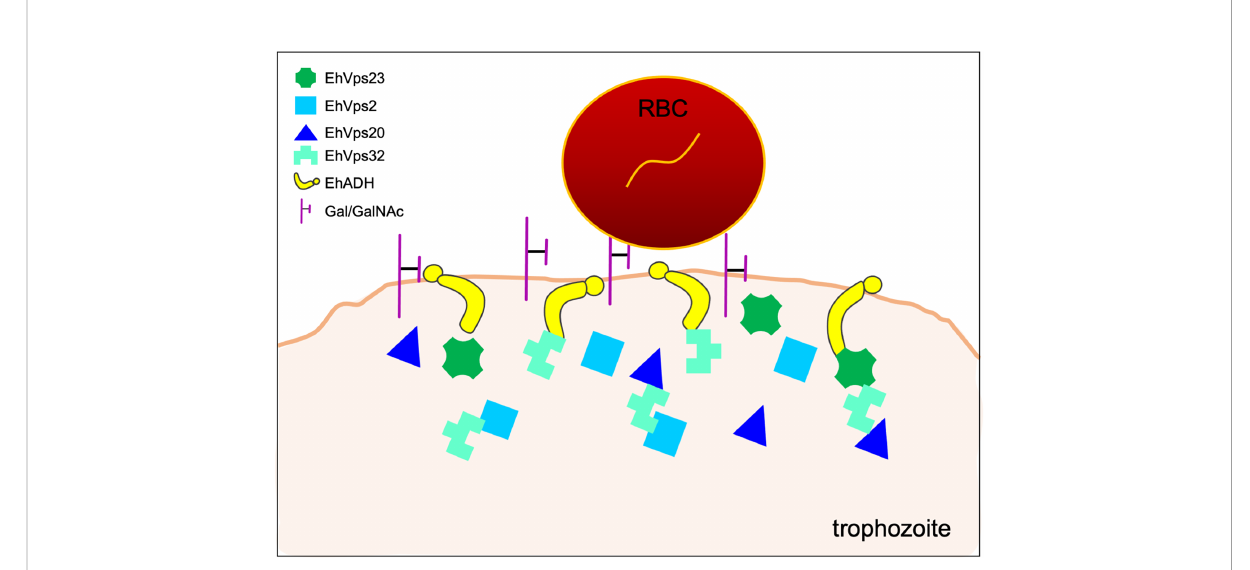
FIGURE 1 Initial contact of trophozoites with RBCs. During the capture of the prey by trophozoites, the EhADH adhesin and the Gal/GalNAc lectin participate. At the contact site, some ESCRT-I and ESCRT-III components are localized, suggesting their role in this